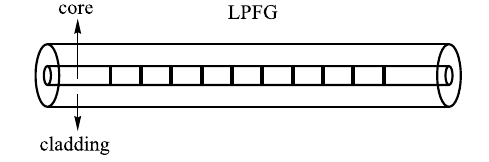
Fig. 3 Schematic diagram of the long-period fiber gratings (LPFG)